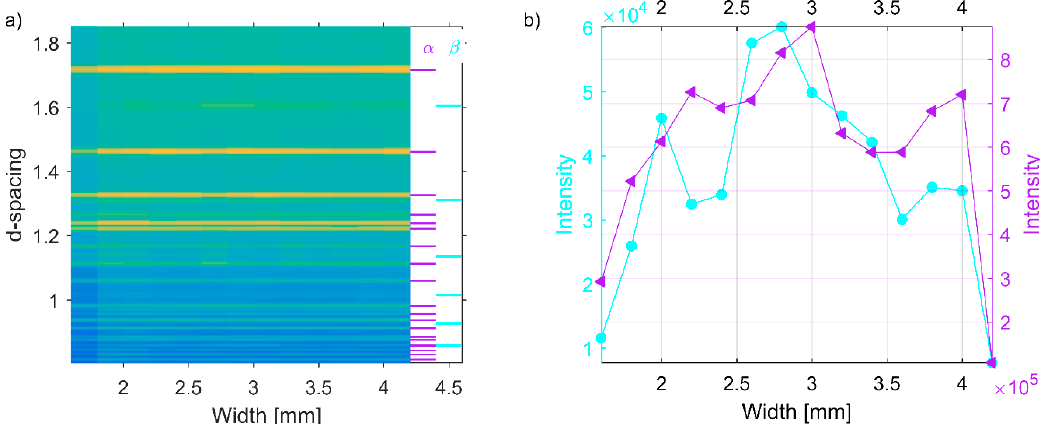
Figure 7. ( a ) Accumulated diffraction patterns of horizontal line scan along the build plane of specimen S8, and ( b ) corresponding peak intensity of (002) β‐ Ti (magenta) and (012) α‐ Ti (purple).